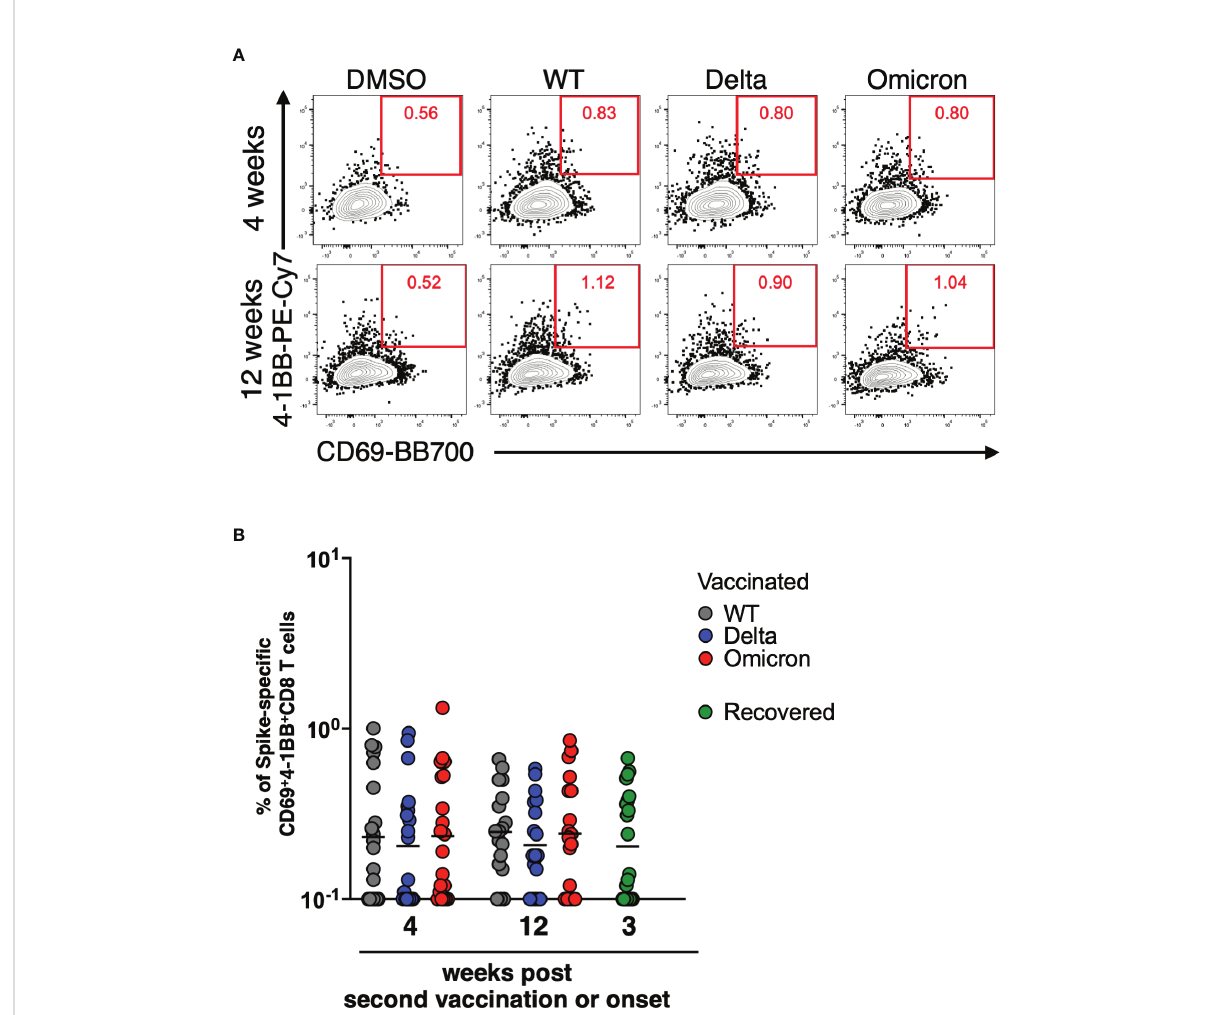
FIGURE 2 CD8 + T cells induced by mRNA vaccine against SARS-CoV-2 variants of concern. (A) After gating CD8 + memory T cells as in Supplemental Figure 1A, SARS-CoV-2 spike-speci fi c CD8 + T cells were de fi ned as the CD69 + 4-1BB + population. (B) Comparison of spike-speci fi c CD69 + 4- 1BB + CD8 + T cell frequency against WT (4 weeks; 0.1% – 1%, geometric mean = 0.23%, 12 weeks; 0.1% – 0.66%, geometric mean = 0.24%), Delta (4 weeks; 0.1% – 0.94%, geometric mean = 0.20%, 12 weeks; 0.1% – 0.58%, geometric mean = 0.21%), and Omicron (4 weeks; 0.1% – 1.32%, geometric mean = 0.23%, 12 weeks; 0.1% – 0.85%, geometric mean = 0.24%) spike peptides in CD8 + total memory cells at 4 and 12 weeks post second vaccination ( n = 21) and spike-speci fi c CD69 + 4-1BB + CD8 + T cell frequency against Alpha spike peptides in CD8 + total memory cells from recovered donors (0.1 – 0.67%, geometric mean = 0.20%; n = 21) The lines show the geometric